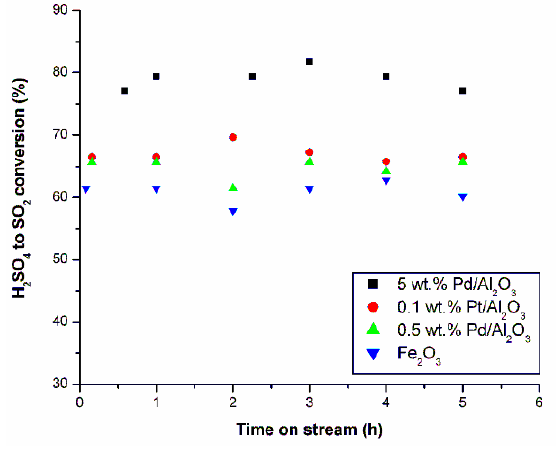
Figure 2. Catalyst activity based on H